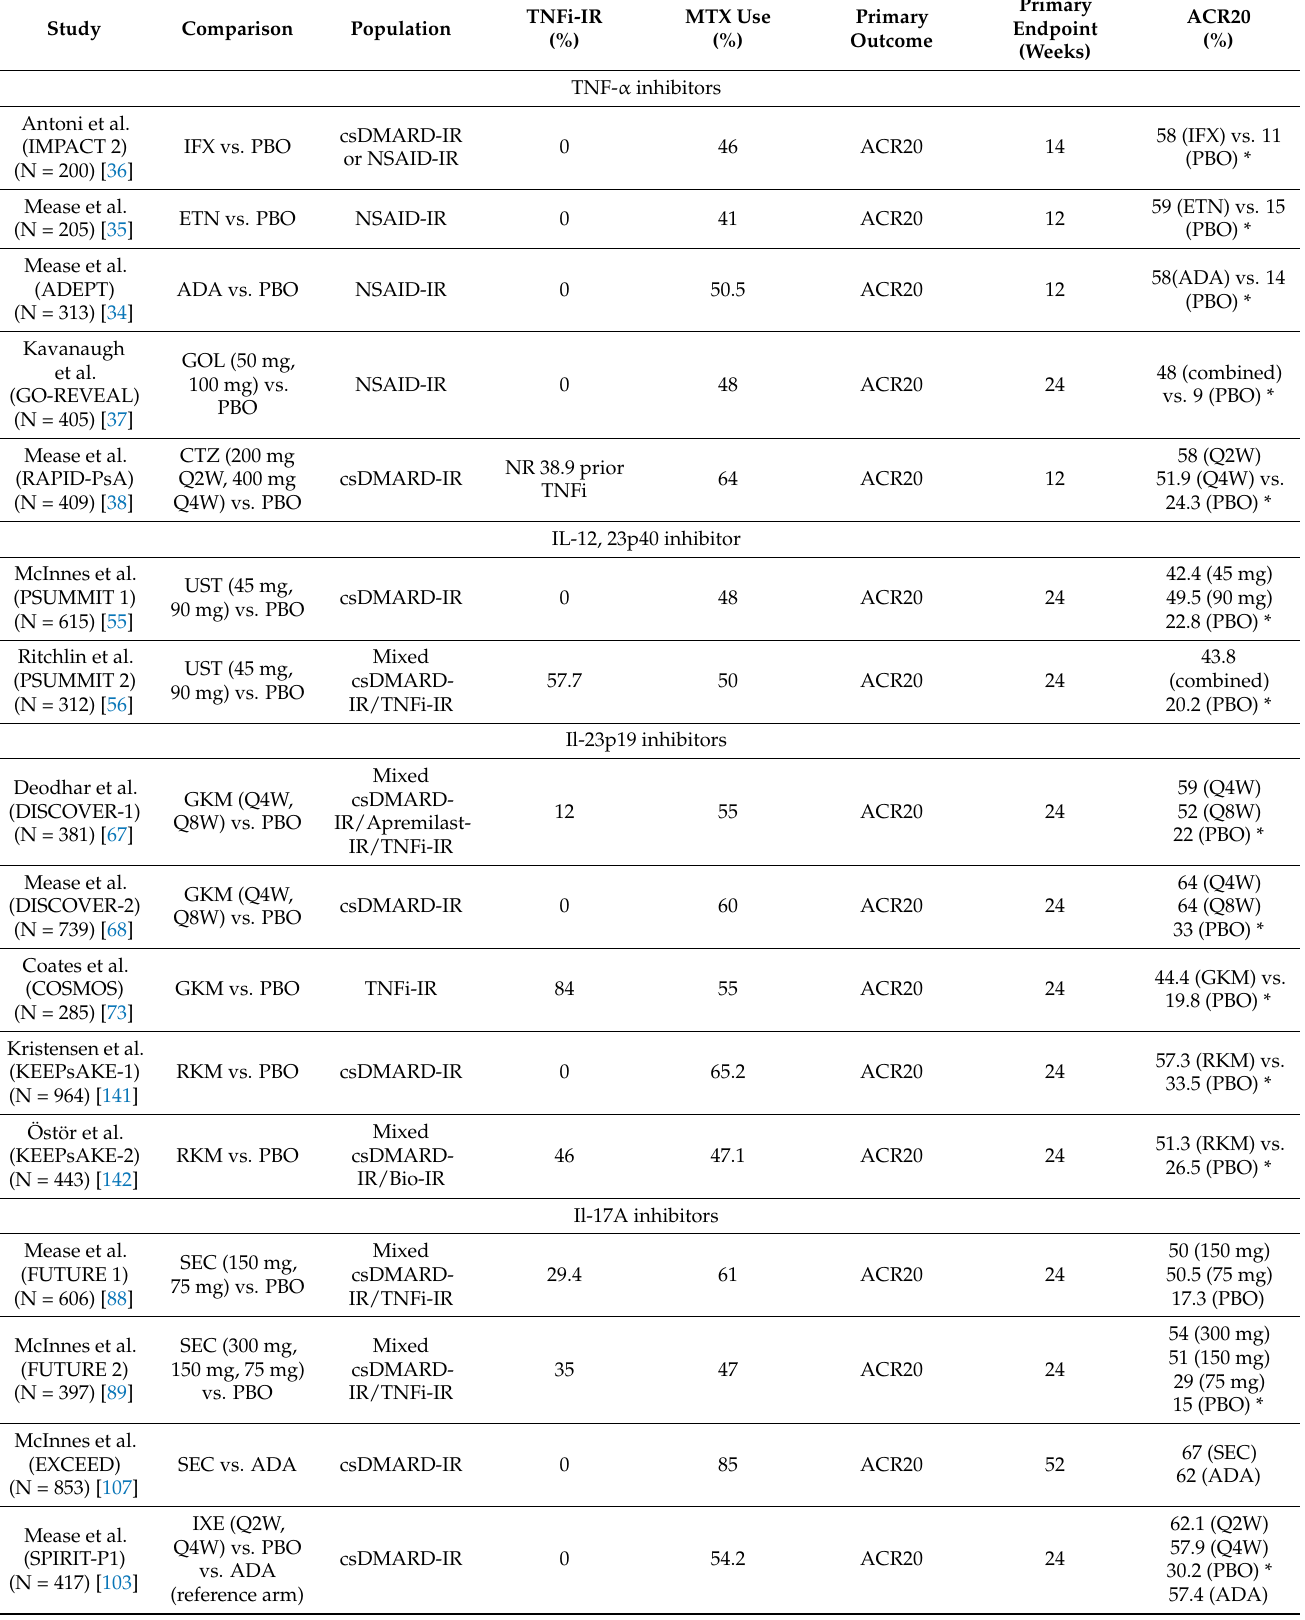
Table 2. Clinical trials in psoriatic